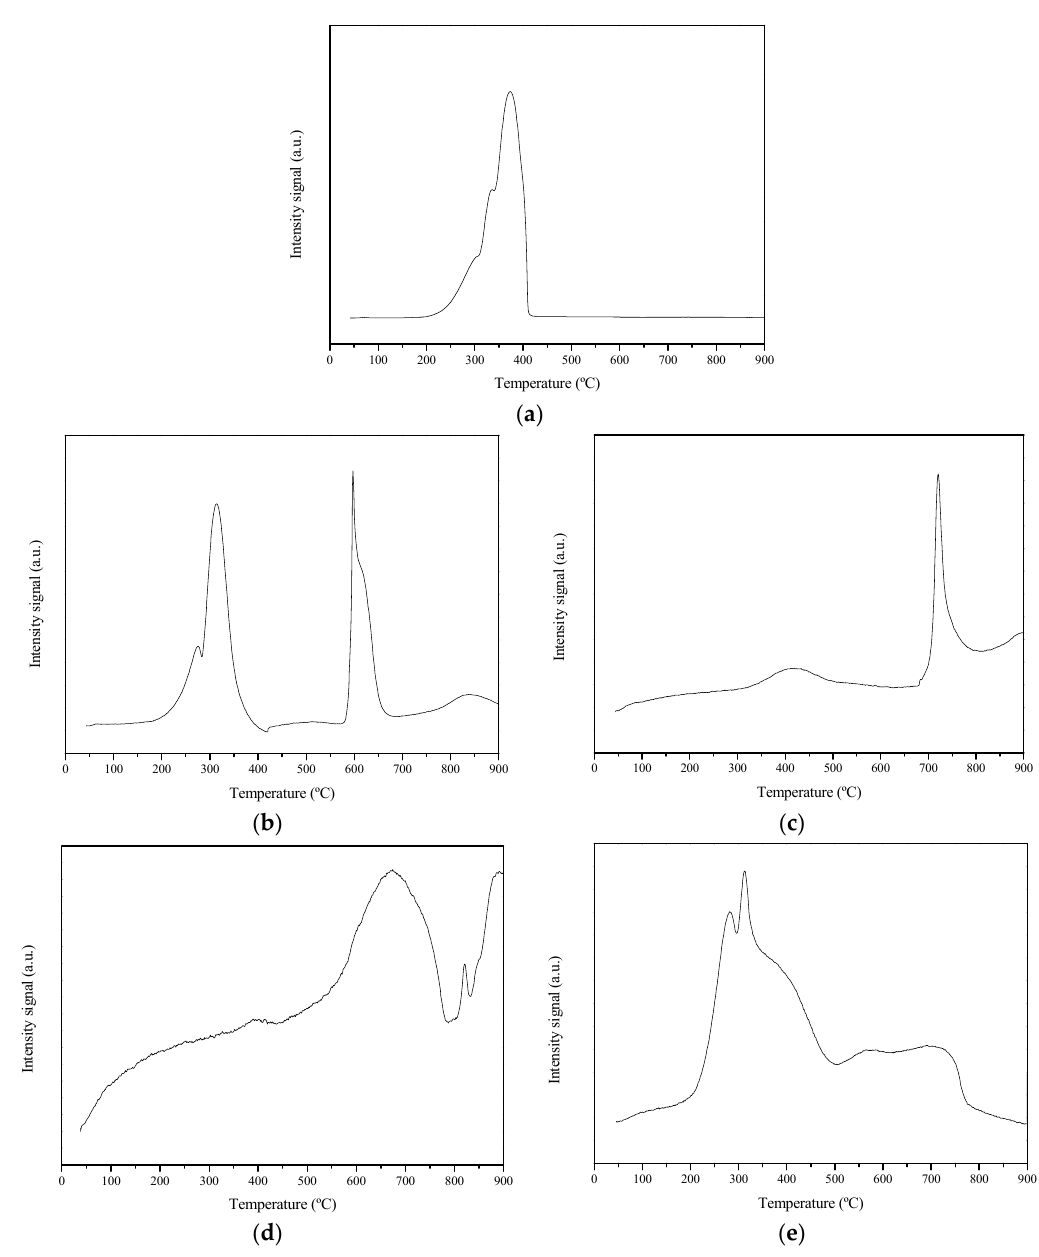
Figure 6. TPR profiles: ( a ) Bulk Co 3 O 4 ; ( b ) CoN/SiC; ( c ) CoA/SiC; ( d ) CoCl/SiC; and ( e ) CoCit/SiC.